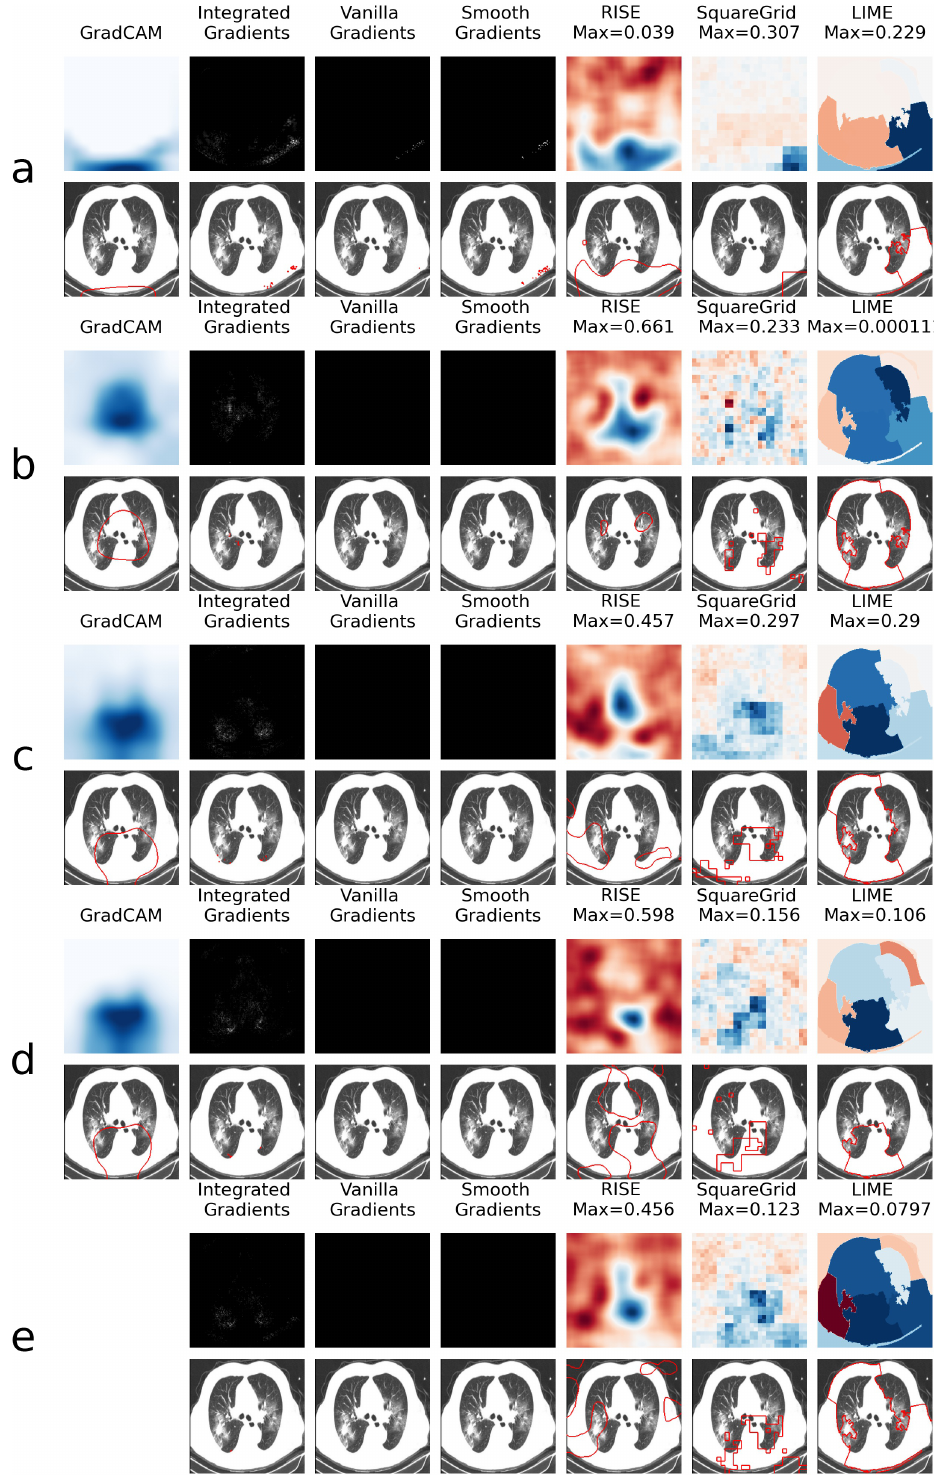
Figure 5. Comparison of XAI heatmaps for image without colored artifacts: ( a ) VGG val 831 . ( b ) Ef f val 856 . ( c ) Dense val 898 . ( d ) Dense val 907 . ( e ) Ensemble. See the caption of Figure 4 for de- tails on heatmap